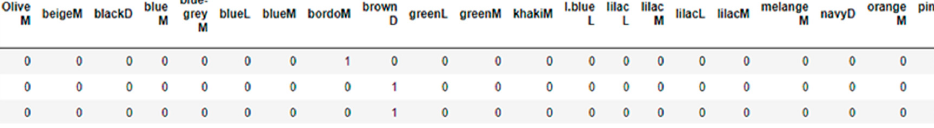
Figure 16. An example of the processed dataset after one-hot encoding the column